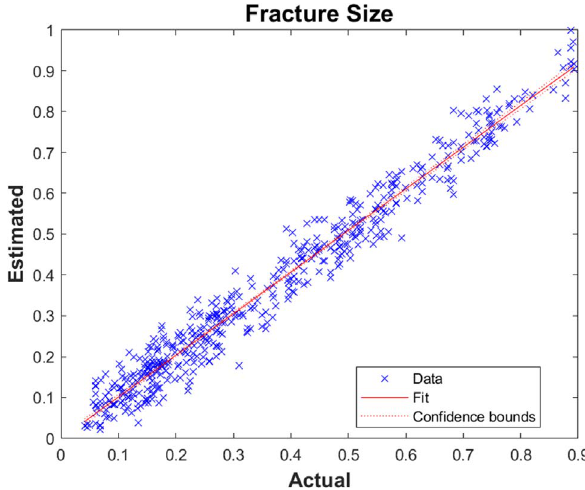
Figure 7. Comparison of estimated versus actual fracture sizes for the image deep learning framework for the testing